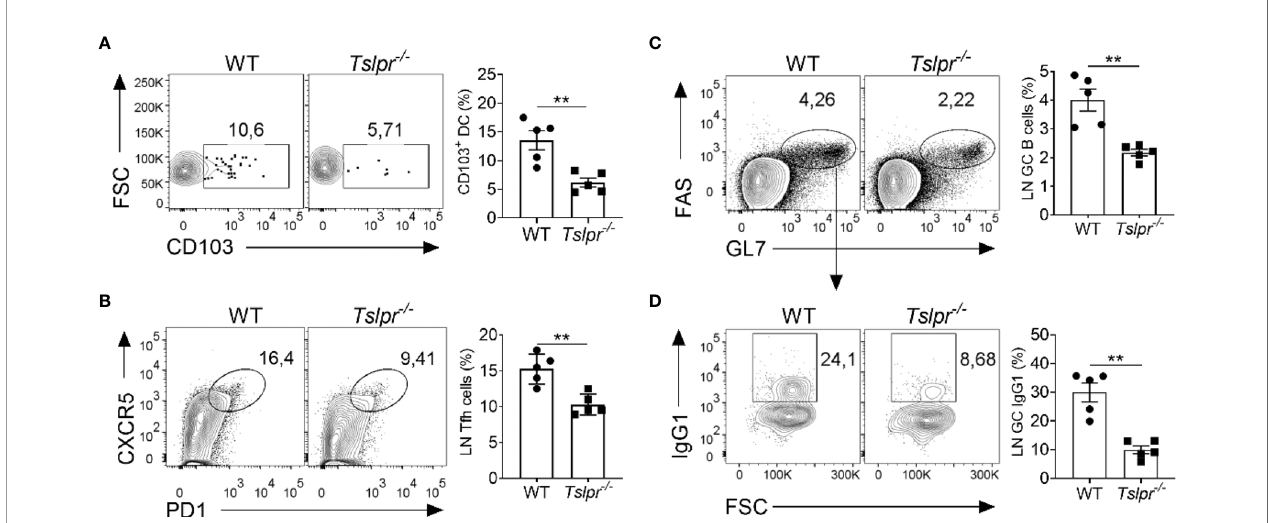
FIGURE 3 | TSLPR de fi ciency impairs migration of DCs and limits germinal center reaction in draining lymph nodes of mice infected with live-attenuated in fl uenza virus. (A) B6-WT (n = 5) and Tslpr – / – mice (n = 5) were intranasally infected with live-attenuated in fl uenza A virus strain hvPR8- D NS1, and the frequency of CD103 + DCs among live CD11c + MHC-II + immune cells were determined at day 5 post-infection. (B – D) B6-WT (n = 5) and Tslpr – / – mice (n = 5) were intranasally infected with hvPR8- D NS1. Mice were sacri fi ced on day 10 post-infection and cells in draining lymph nodes were analyzed by fl ow cytometry for (B) Tfh cells among live CD19 − CD4 + CD44 + cells. (C) Germinal center B cells among live CD4 - B220 + cells or (D) IgG1 + germinal center B cells among live CD4 − B220 + GL7 + Fas + cells. Each symbol represents the result from an individual animal. **P < 0.01 by unpaired two-tailed Student ’ s t-test. Results are representative of three independent experiments and shown as mean ±